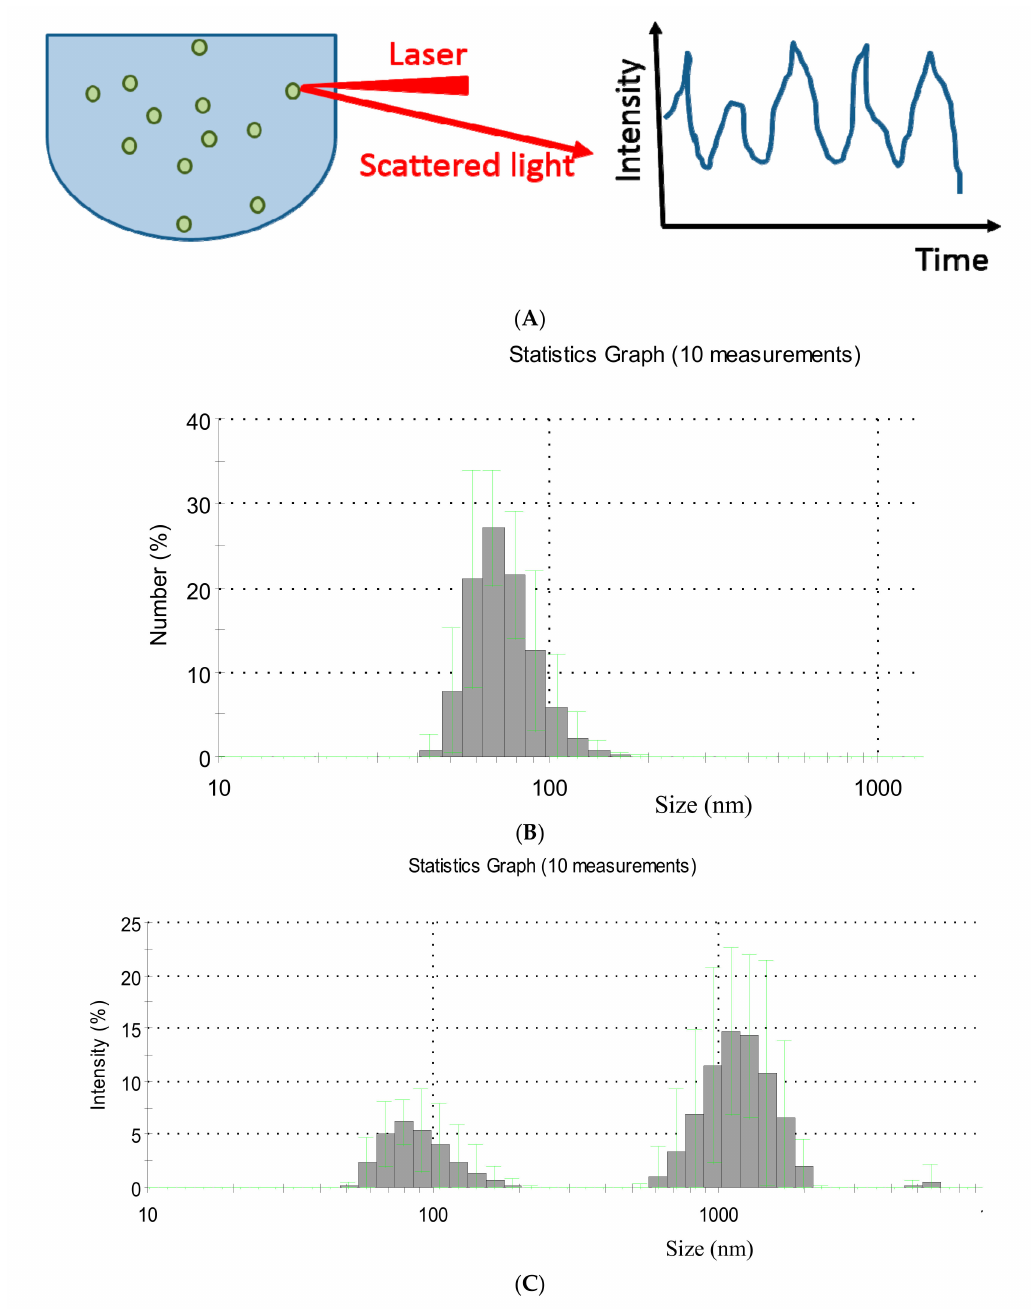
Figure 3. ( A ) The principle of the dynamic light scattering; ( B , C ) Exemplary spectra of dynamic light scattering (DLS) measurements of EVs present in human plasma of gastric cancer patient: ( B ) The most numerous EVs population in the sample; ( C ) EVs size